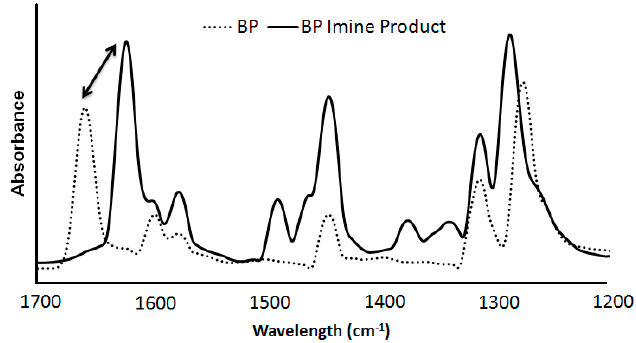
Figure 3. FTIR of pure BP (dashed) compared to isolated BP imine product (solid). Table 3. Determined BP conversion from GC analysis compared to BP conversion calculated from IR spectral C=N/C=O absorbance ratio.